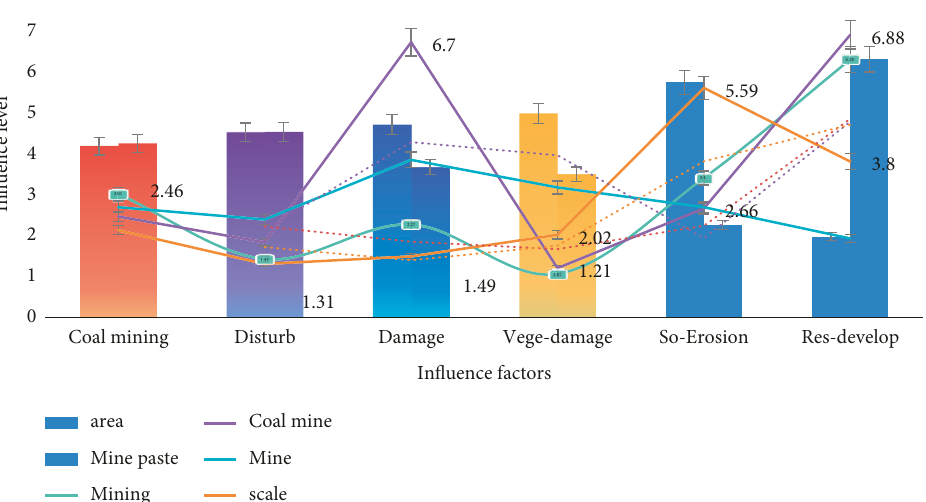
Figure 7: The load acting on the segment structure opposite tension and hoop load.